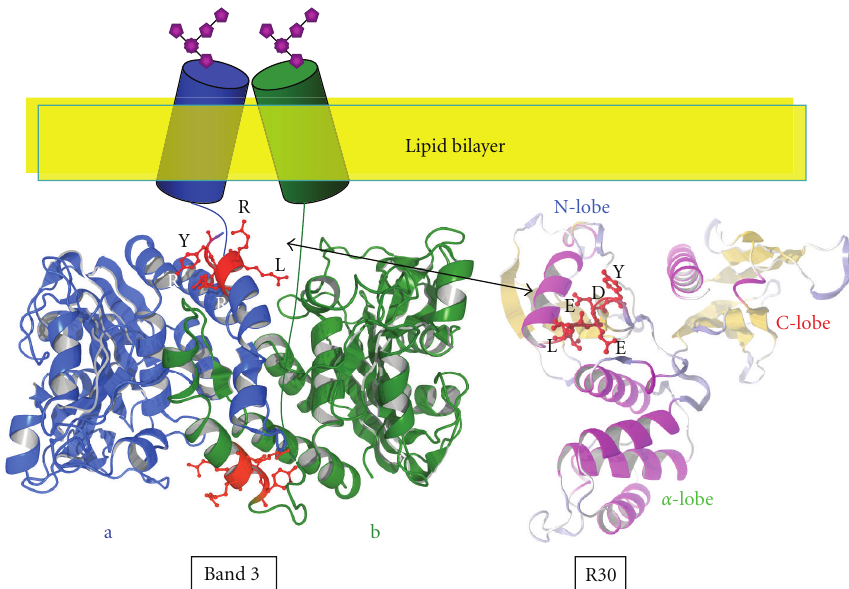
Figure 3: Characteristics of 4.1R interaction with band 3. Band 3 forms dimers in the membrane ( a and b ). The LRRRY sequence mediates interaction between monomers and is located in an α -helix. The band 3 binding sequence LEEDY, which mediates interaction with 4.1R, is located in the loop structure [15] (PDB accession no. 1hyn). There is no information about the stoichiometry of band 3 binding to